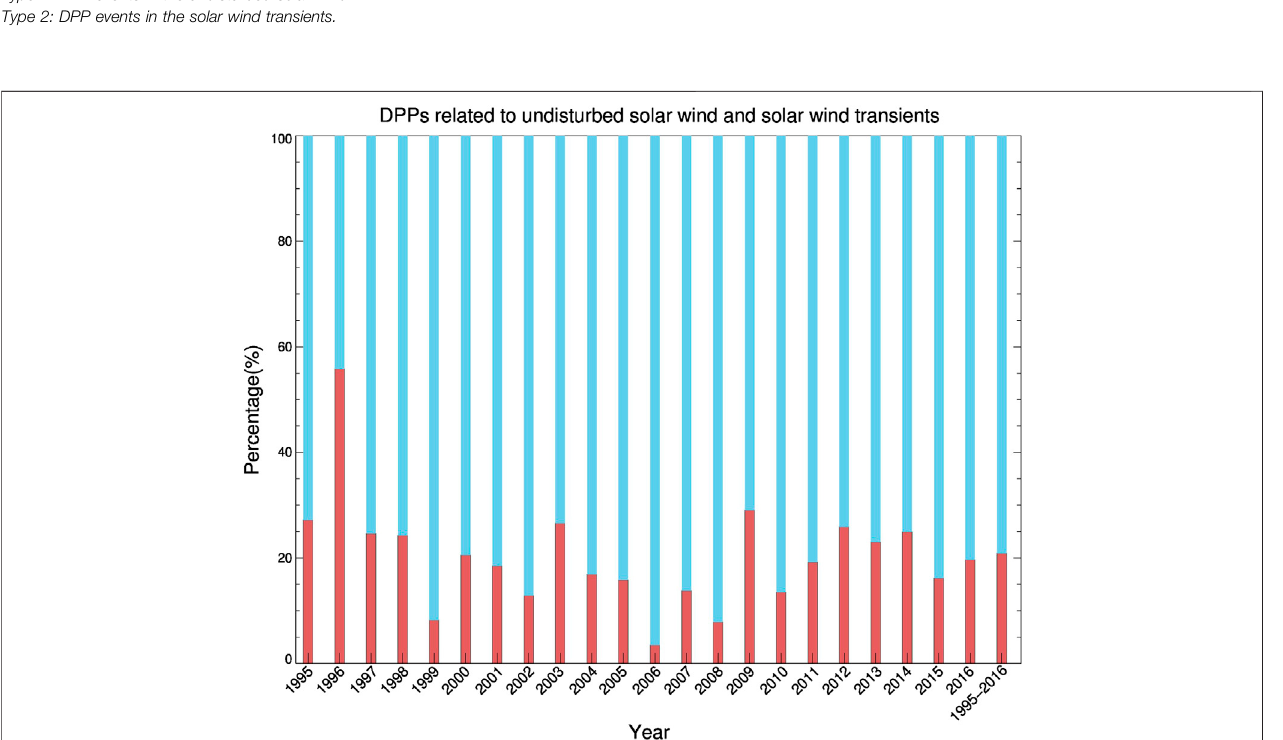
Frontiers in Physics |